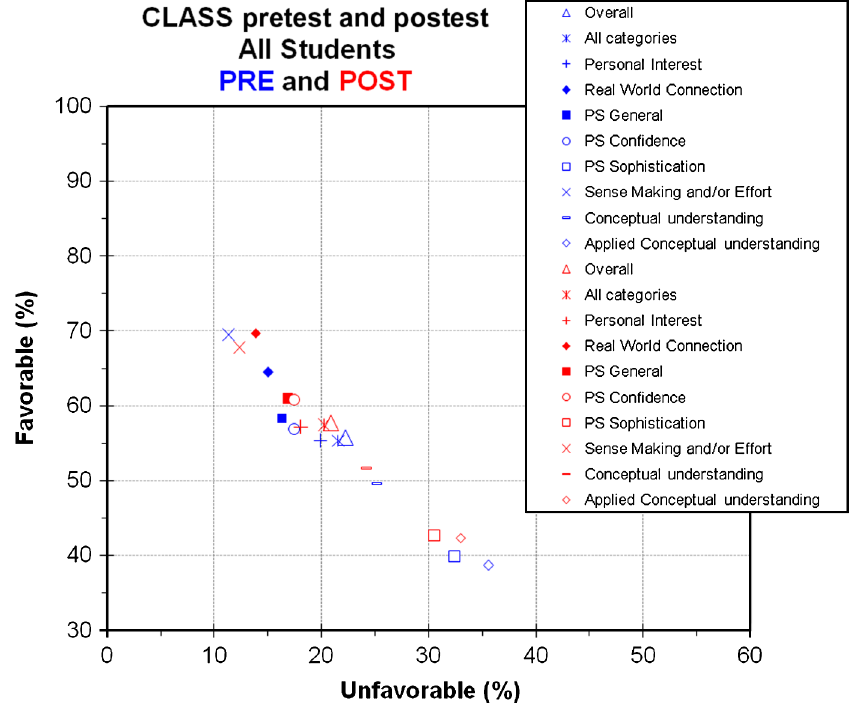
FIG. 1 (color online). CLASS results in week 2 and week 12 of an introductory physics course. Week 2 results are shown in blue, while week 12 results are shown in red. PS, problem solving.